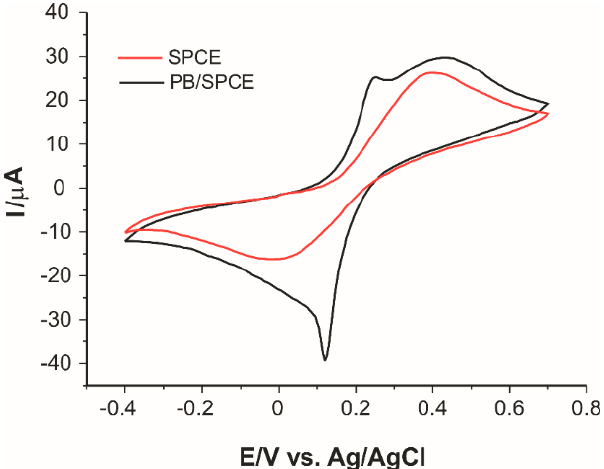
Figure 1. Cyclic voltammograms of the SPCE sensor (red line) and of the PB/SPCE sensor (black line) immersed in the solution obtained of potassium ferrocyanide 10 − 3 M—potassium chloride 10 − 1 M. The scan rate was 0.1 V·s − 1 .